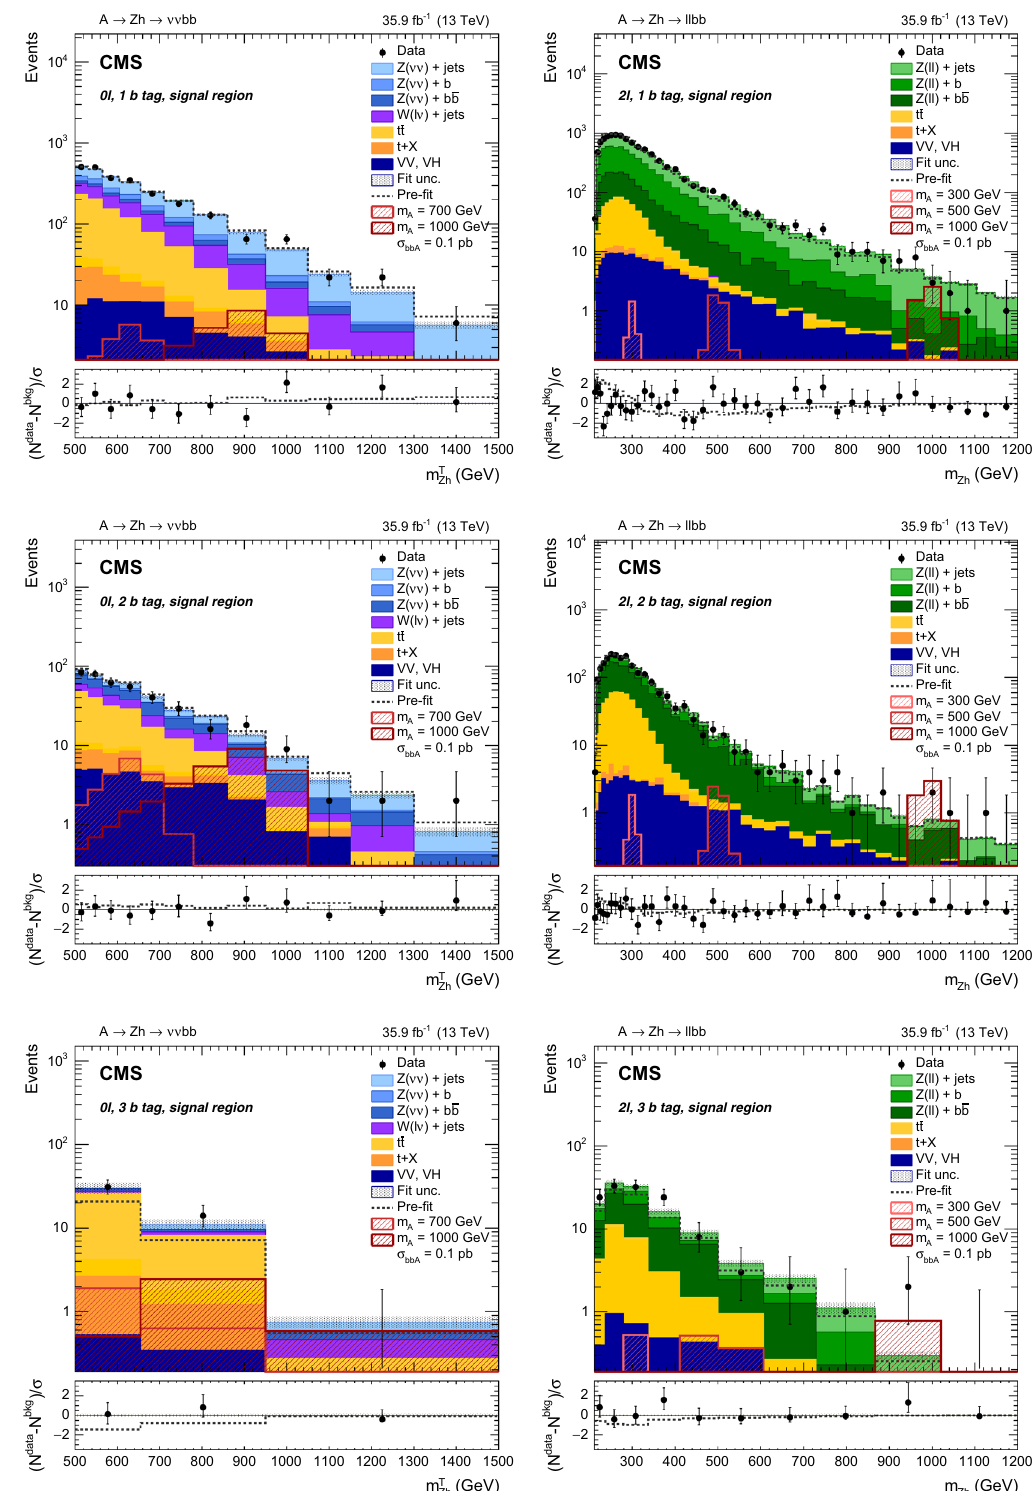
Fig. 4 Distributions of the m T variable in the 0 (cid:5) categories (left) and represents the post-fit uncertainty. The hatched red histograms repre- Zh m Zh in the 2 (cid:5) categories (right), in the 1 b tag (upper), 2 b tag (cen- sent signals produced in association with b quarks and corresponding ter), and 3 b tag (lower) SRs. In the 2 (cid:5) categories, the contribution to σ A B ( A → Zh ) B ( h → b ¯ b ) = 0 . 1 pb . The bottom panels depict the of the 2e and 2 μ channels have been summed. The gray dotted line pullsineachbin, ( N data − N bkg )/σ ,where σ isthestatisticaluncertainty represents the sum of the background before the fit; the shaded area in